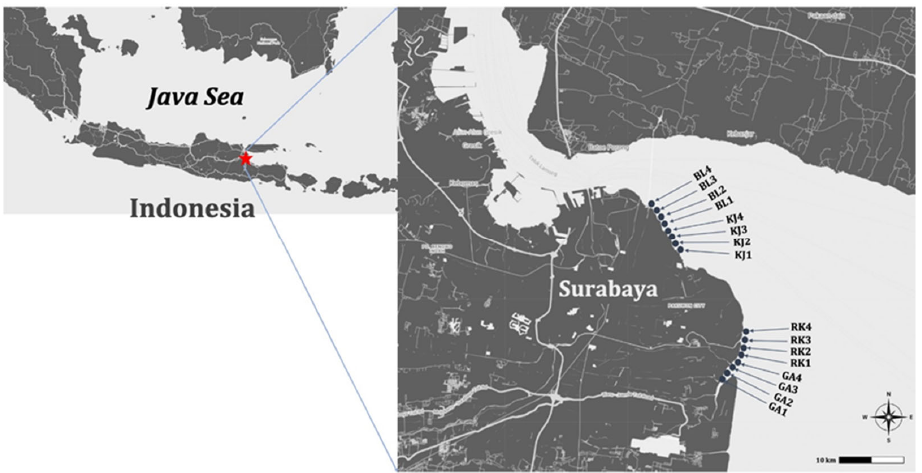
Figure 1. Study area and sampling